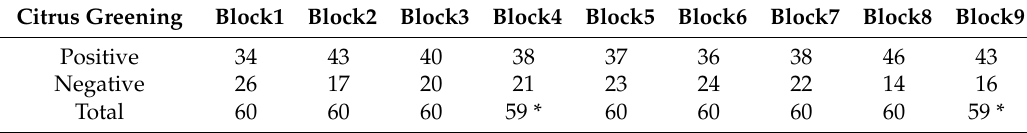
Table 1. Numbers of trees in the citrus greening positive and negative groups in all blocks. Citrus